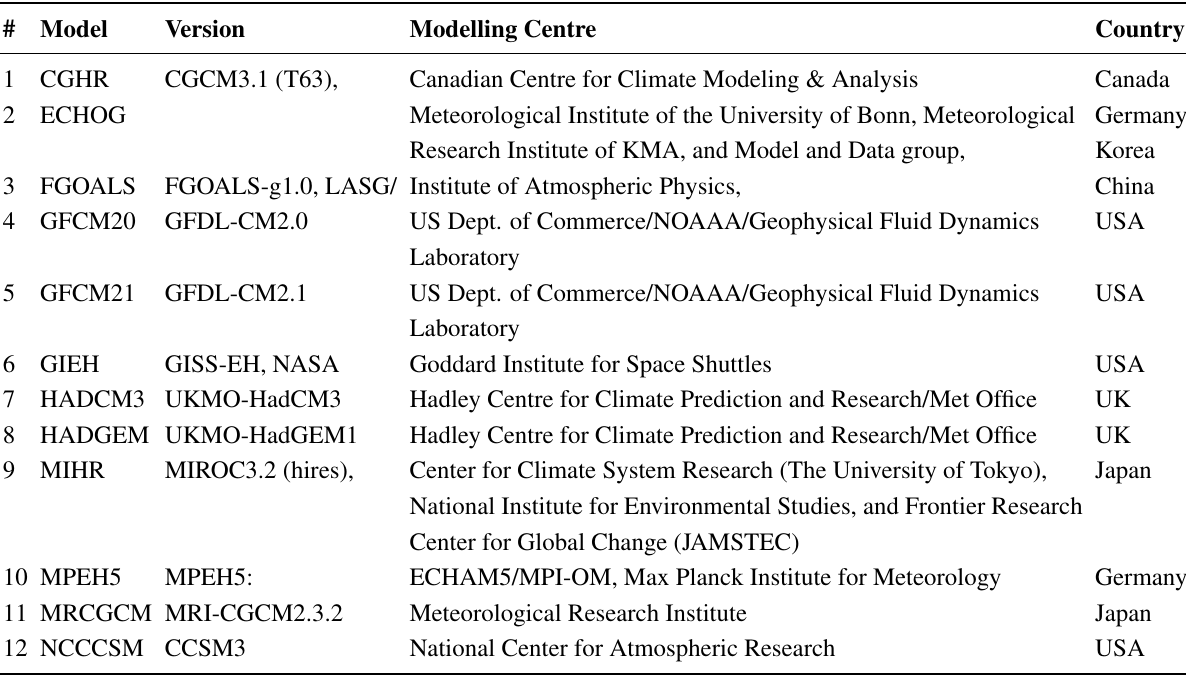
Table 3. GCMs used in the projections of future 2050 runoff changes after [5].